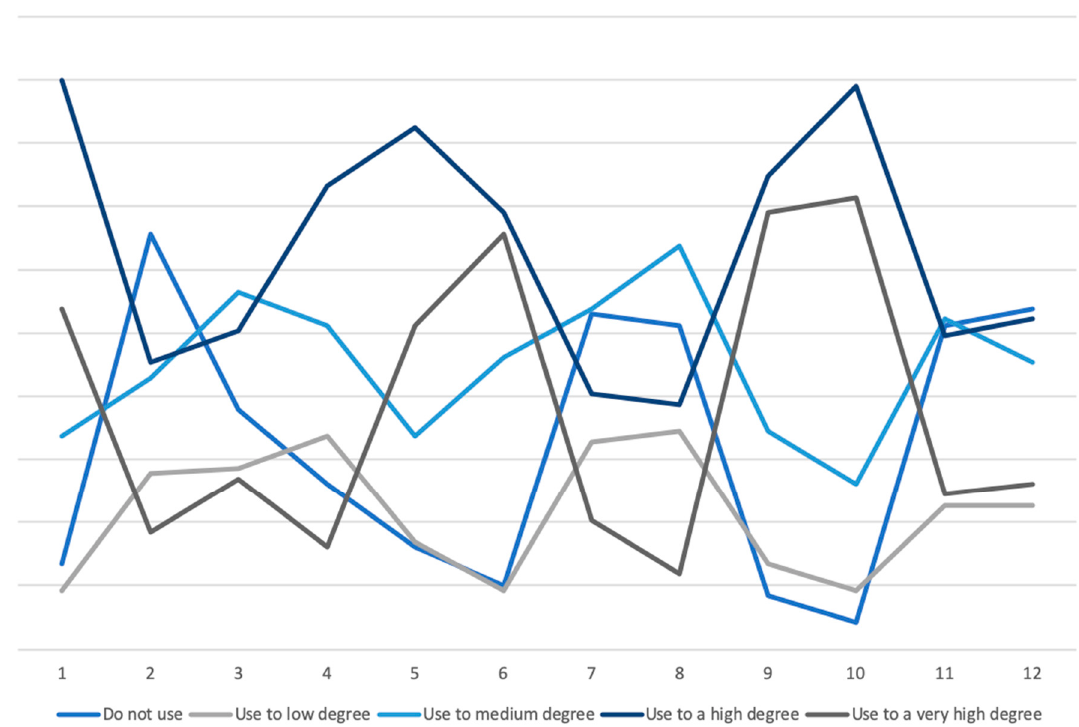
Figure 3. Industry 4.0 technologies (line chart).